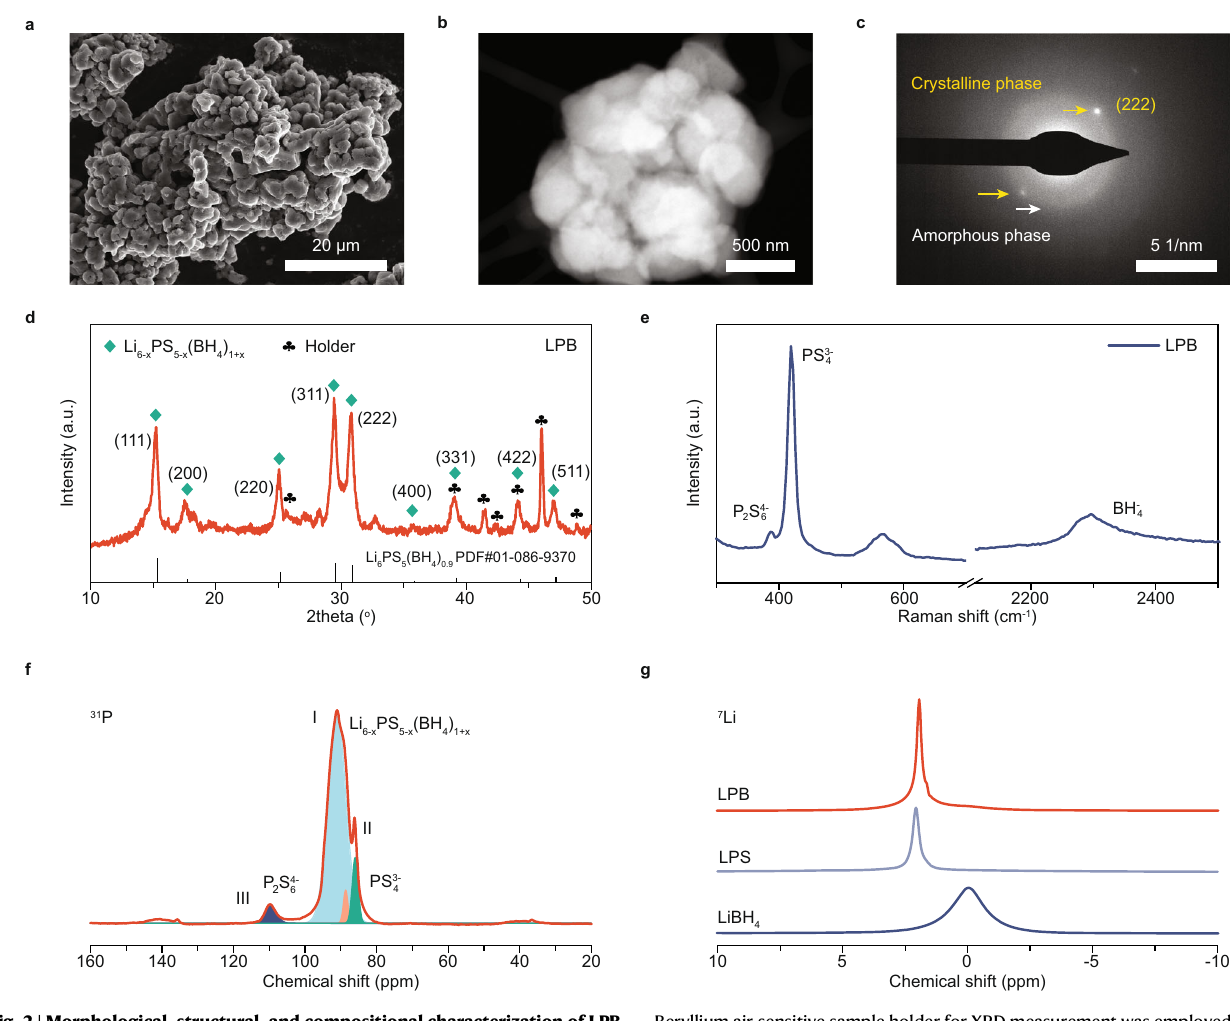
Beryllium air-sensitive sample holderfor XRD measurement wasemployed with its background patterns presented in Supplementary Fig.